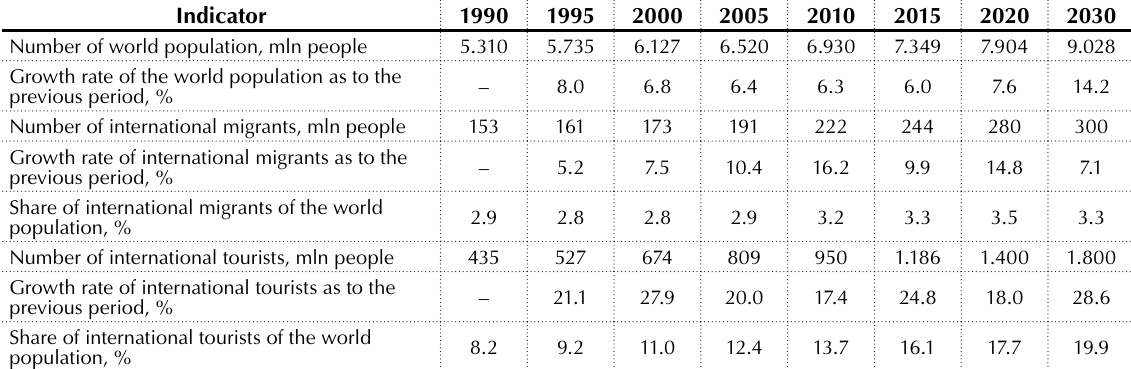
Table 2. Dynamics and forecast of global demographic